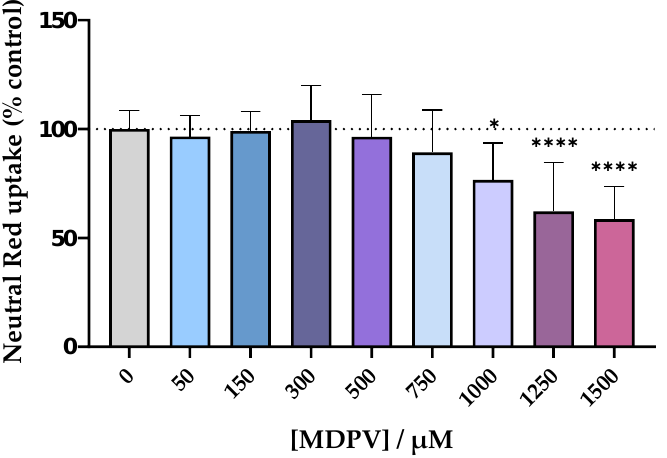
Figure 5. Cytotoxicity evaluation in Caco-2 cells exposed to racemic MDPV (0 – 1500 µM) for 24 h performed by the NR assay. Results are expressed as mean ± SD from four independent experiments (performed in triplicate). * p < 0.05, **** p < 0.0001 vs. control (0 µM).